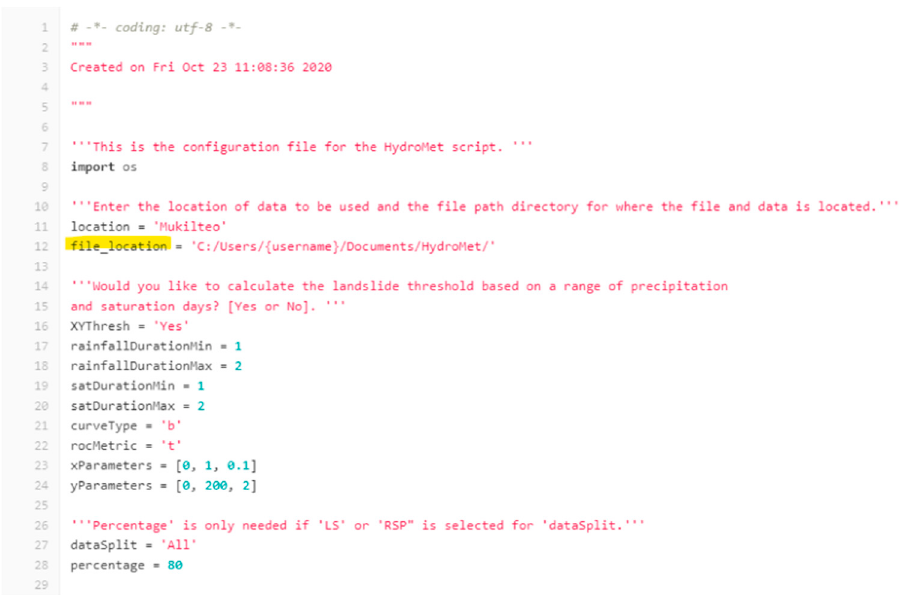
Figure 5. First 29 lines of the configuration script ConfigHydroMet.py. The file location highlighted above in line 12 will need modification to reflect the user’s file directory structure. The use of quotation marks around inputs can be seen in lines 11,12, 16, 21 22, and 27. The use of brackets and commas separating values is seen in lines 23 and 24.